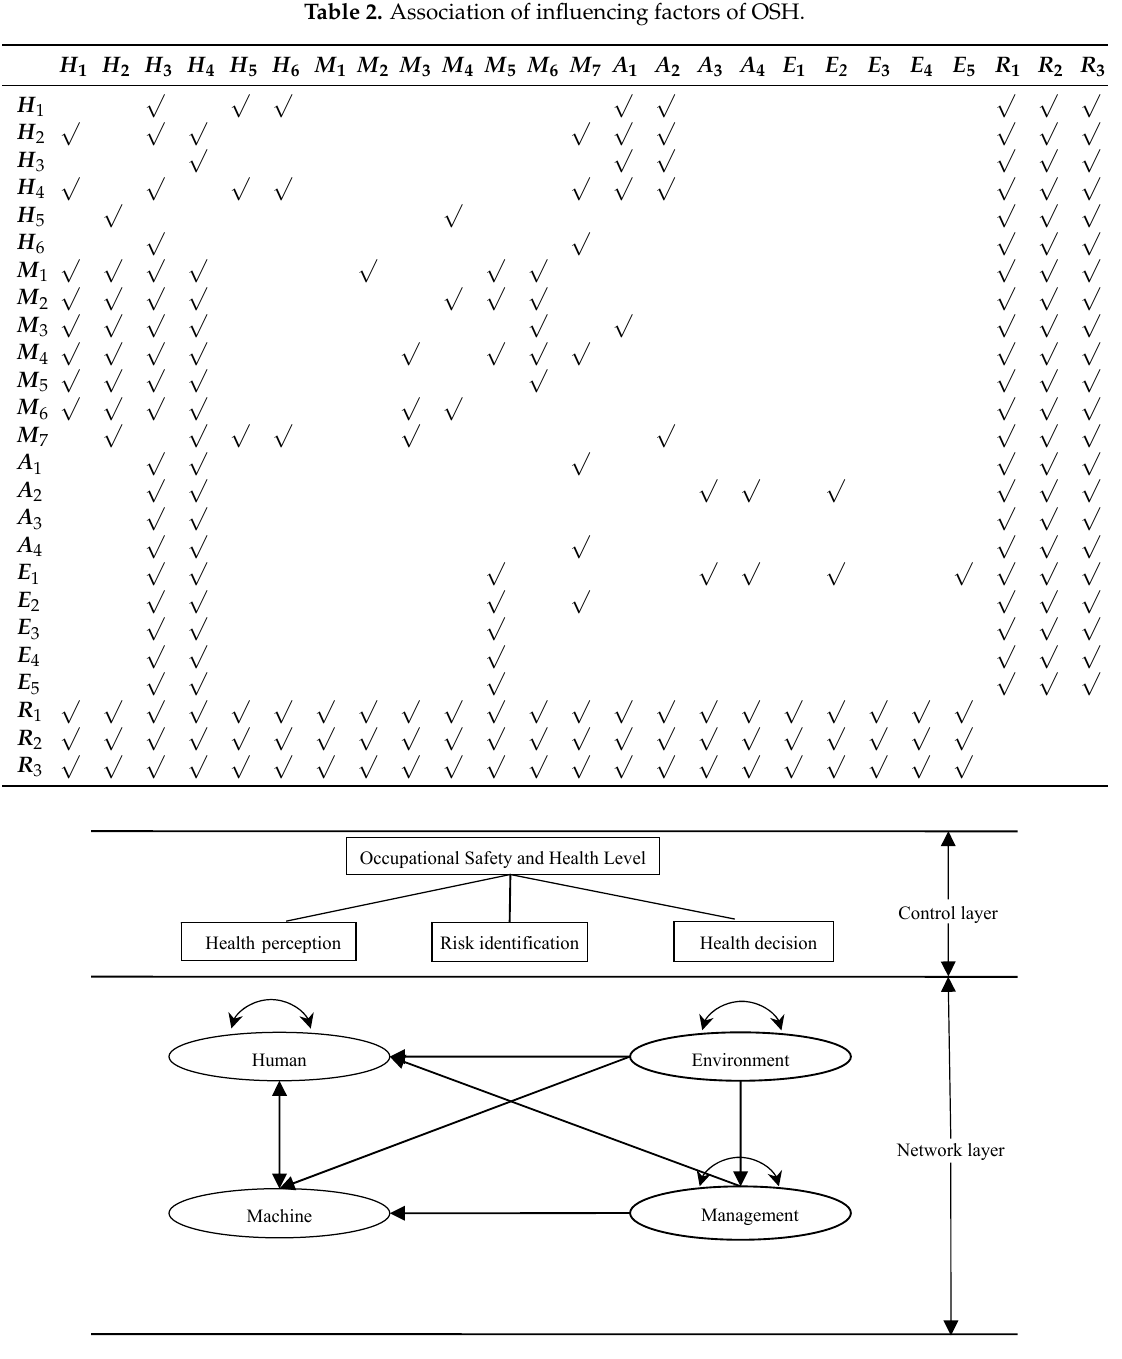
Figure 2. Influencing factors of OSH Analytic Network Process (ANP) model.